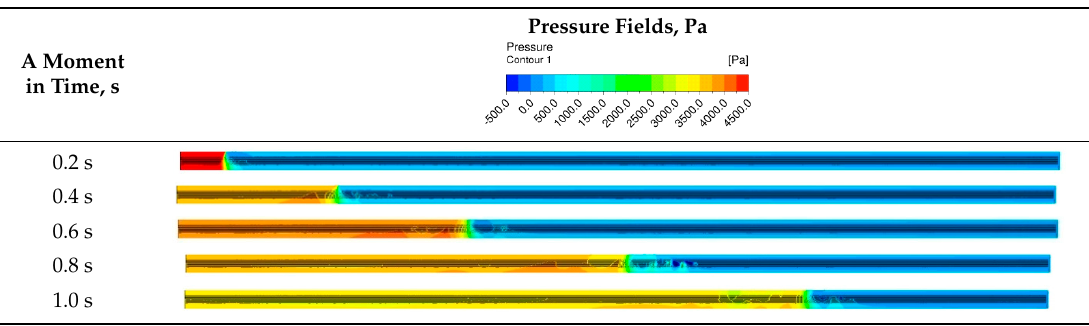
Table 3. Pressure Table 3. Pressure fields. Table 3. Pressure fields. Table 3. Pressure fields. Table 3. Pressure fields. Table 3. Pressure fields. Table 3. Pressure fields.